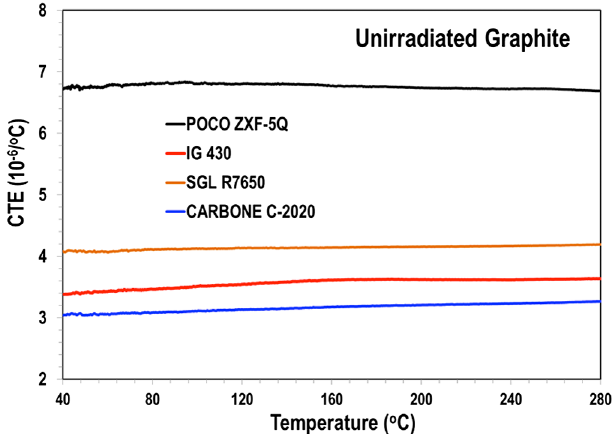
FIG. 7. Thermal expansion coefficient of as-received unirra- diated graphite grades in the temperature range of 40 – 280